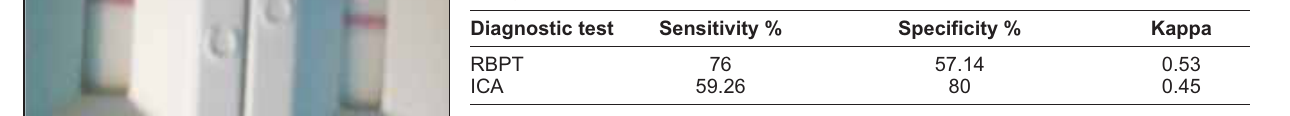
Table-2: The sensitivity, specificity and statistical analysis of ICA and RBPT in comparison with